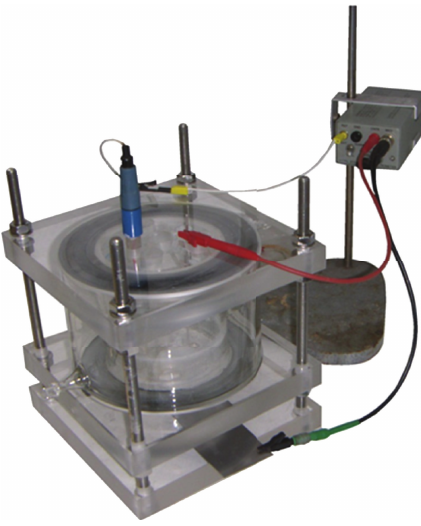
Figure 1: An Avesta type cell and the assembly used in the electrochemical tests.